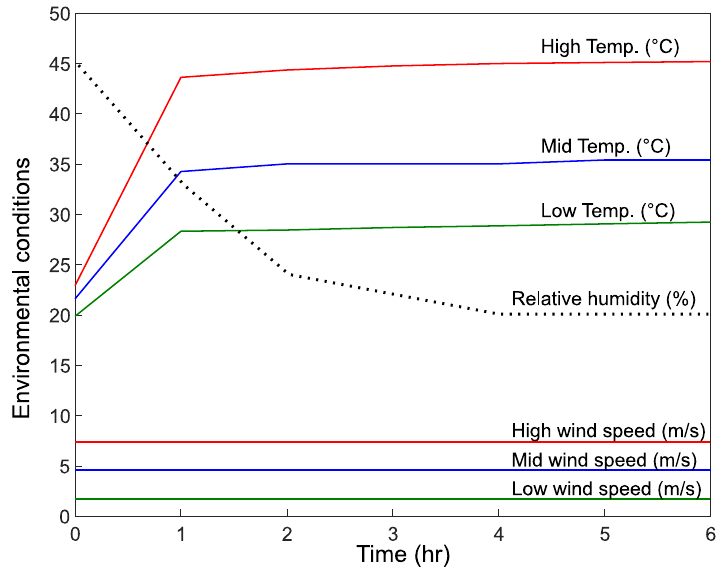
Figure 6. Examined sets of environmental conditions.